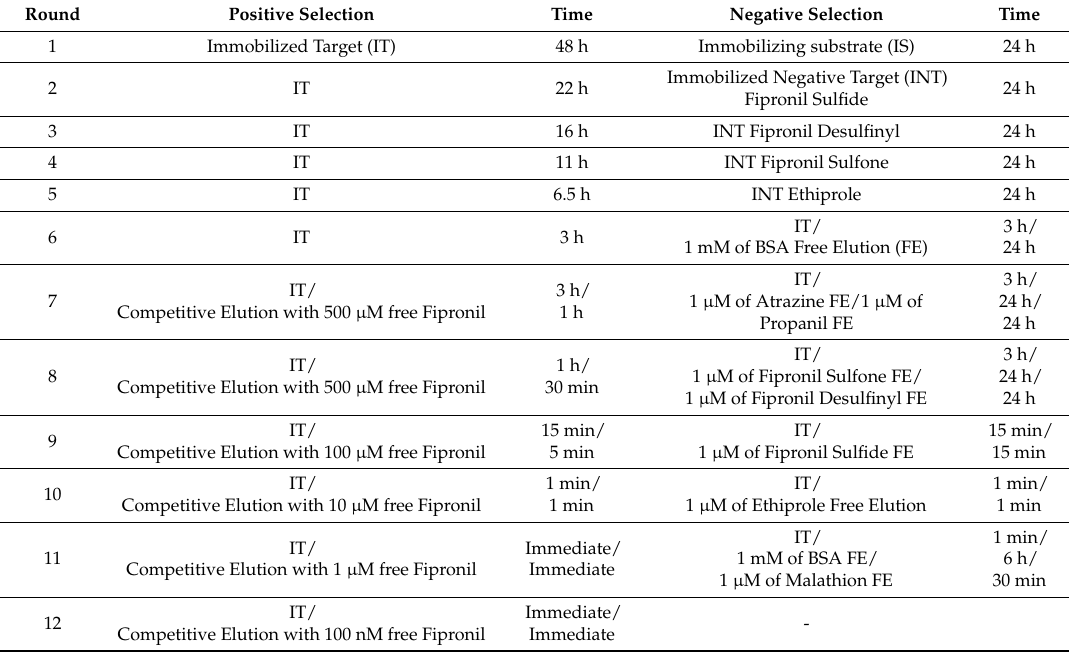
Figure 1. Illustration of the in vitro selection process. The in vitro selection process begins with up to 10 15 different ssDNA molecules (represented by various small, colored shapes) and incubation with the target of interest, fipronil. Molecules that bind to fipronil are amplified and subjected to incubation with negative targets. Those that do not bind to negative targets are isolated and amplified. This completes one round of an in vitro selection cycle. Table 1. Systematic evolution of ligands by exponential enrichments (SELEX) scheme for fipronil-specific molecular recognition element (MRE)